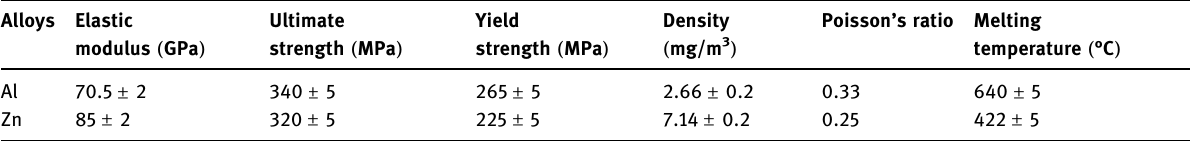
Table 2: Mechanical properties of alloys